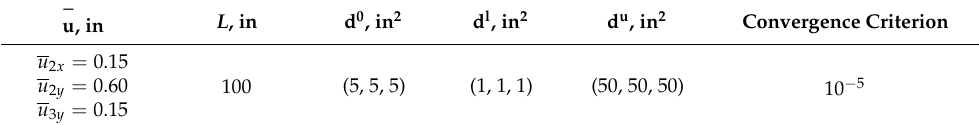
Table 4. Parameters for the objective and constraint functions as well as the RBDO.